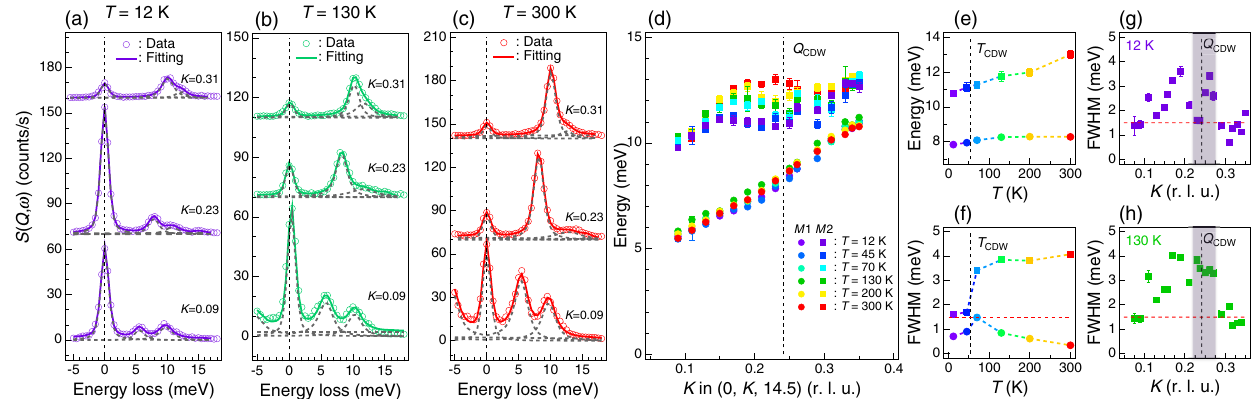
FIG. 3. Phonon line-shape analysis in La 1 Ba 0 CuO 4 . (a) – (c) Example fits of spectra at K ¼ 0 . 09 , 0.23, and 0.31 r.l.u. at . 875 . 125 temperatures of 12, 130, and 300 K, respectively. The individual phonon and elastic components are shown as dashed gray lines. Spectra at K ¼ 0 . 23 and 0.31 r.l.u. are vertically shifted for clarity. (d) – (h) Evolution of fitting parameters. Modes M 1 and M 2 are shown as circles and squares, respectively, and different colors denote different temperatures. (d) The energy dispersion along ð 0 ; K; 14 . 5 Þ through Q (vertical line). (e,f) Temperature-dependent peak energy and width, respectively, at K ¼ 0 . 23 r.l.u. ( Q CDW marks T . (g,h) The Q -dependent peak widths at 12 and 130 K, respectively. The shaded gray region at Q CDW limited width of the CDW Bragg peak at 12 K. The horizontal red line denotes the experimental energy resolution of 1.5-meV FWHM. Note that width values do not include the experimental energy resolution, as this is separately accounted for by the convolution in Eq. (1) of Ref.